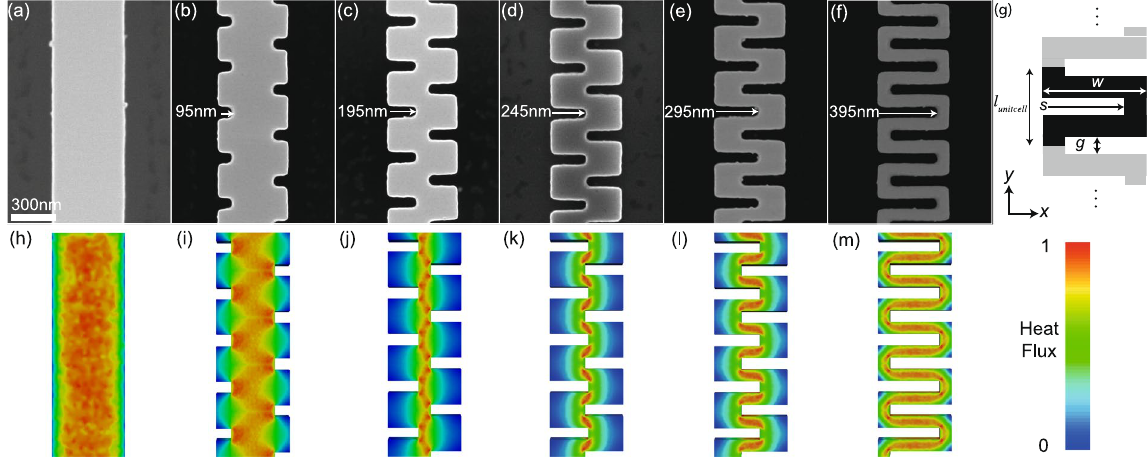
Figure 1. ( a – f ) Magnified view of nanostructured samples with various widths of slits up to 395 nm as marked on the images. ( g ) Schematic of a sample unit cell defining critical geometric dimensions. ( h – m ) Heat flux magnitude of the samples. The heat flux is obtained by solving the Boltzmann transport equation. The heat flux is normalized per sample and shown in the legend.